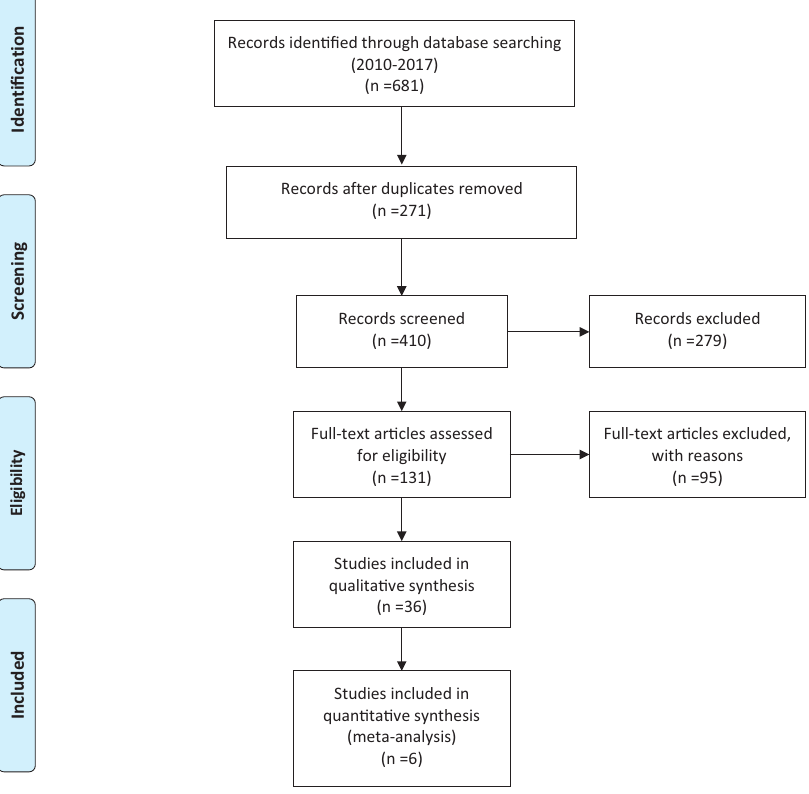
Figure 1. PRISMA